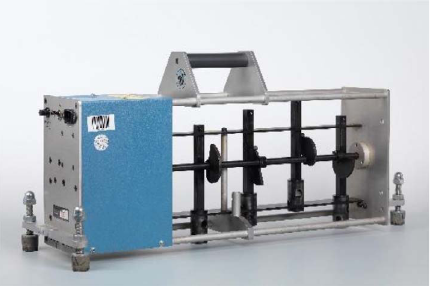
Figure 3. Laboratory tapping machine (LTM), type 1.